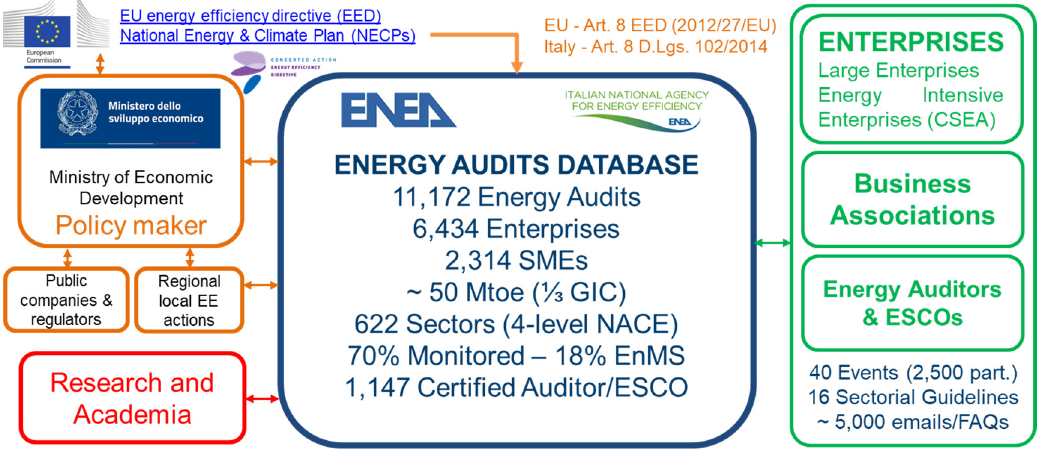
Figure 1. Italian framework of mandatory energy audits as of December 2019.